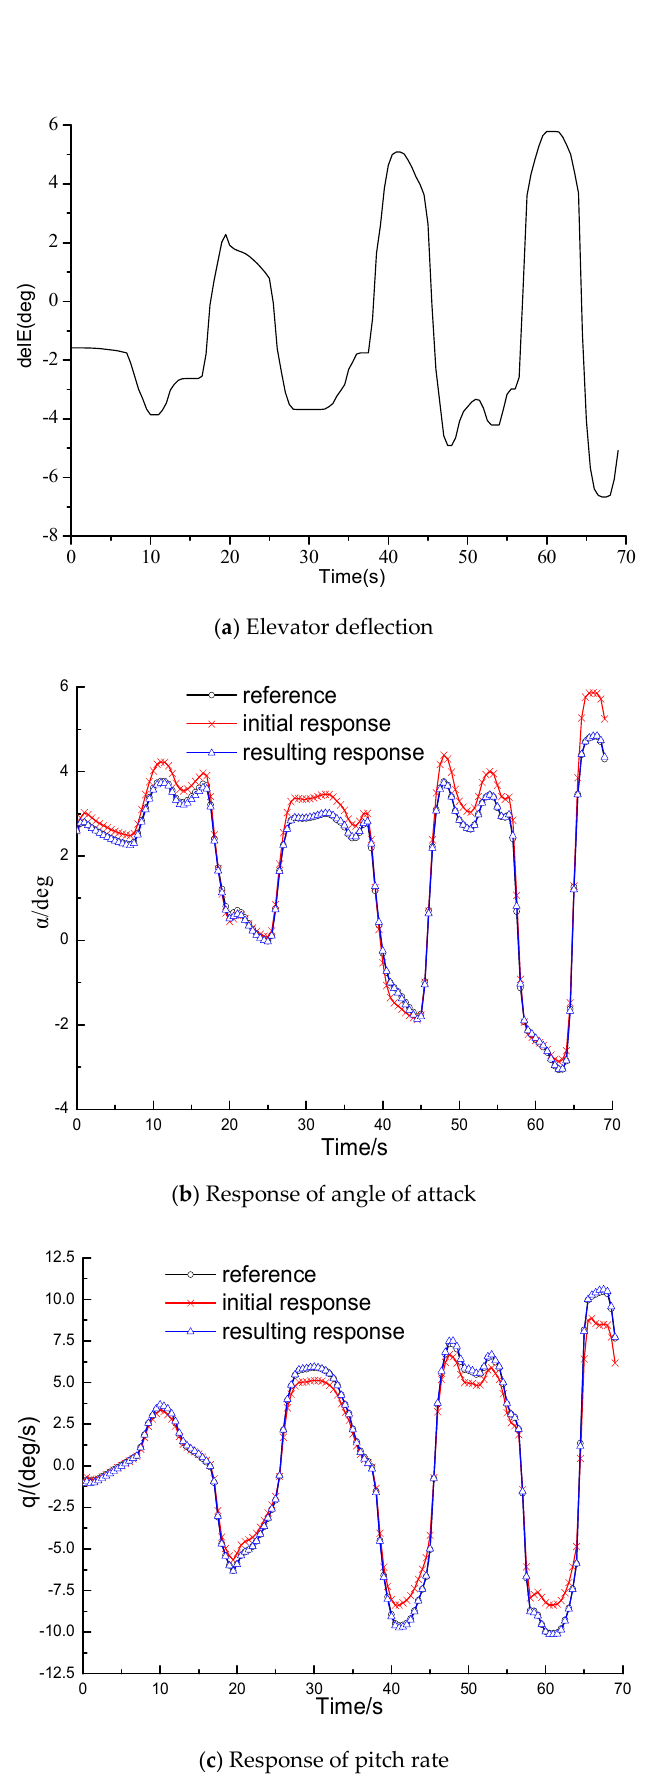
Figure 3. Output responses for the model